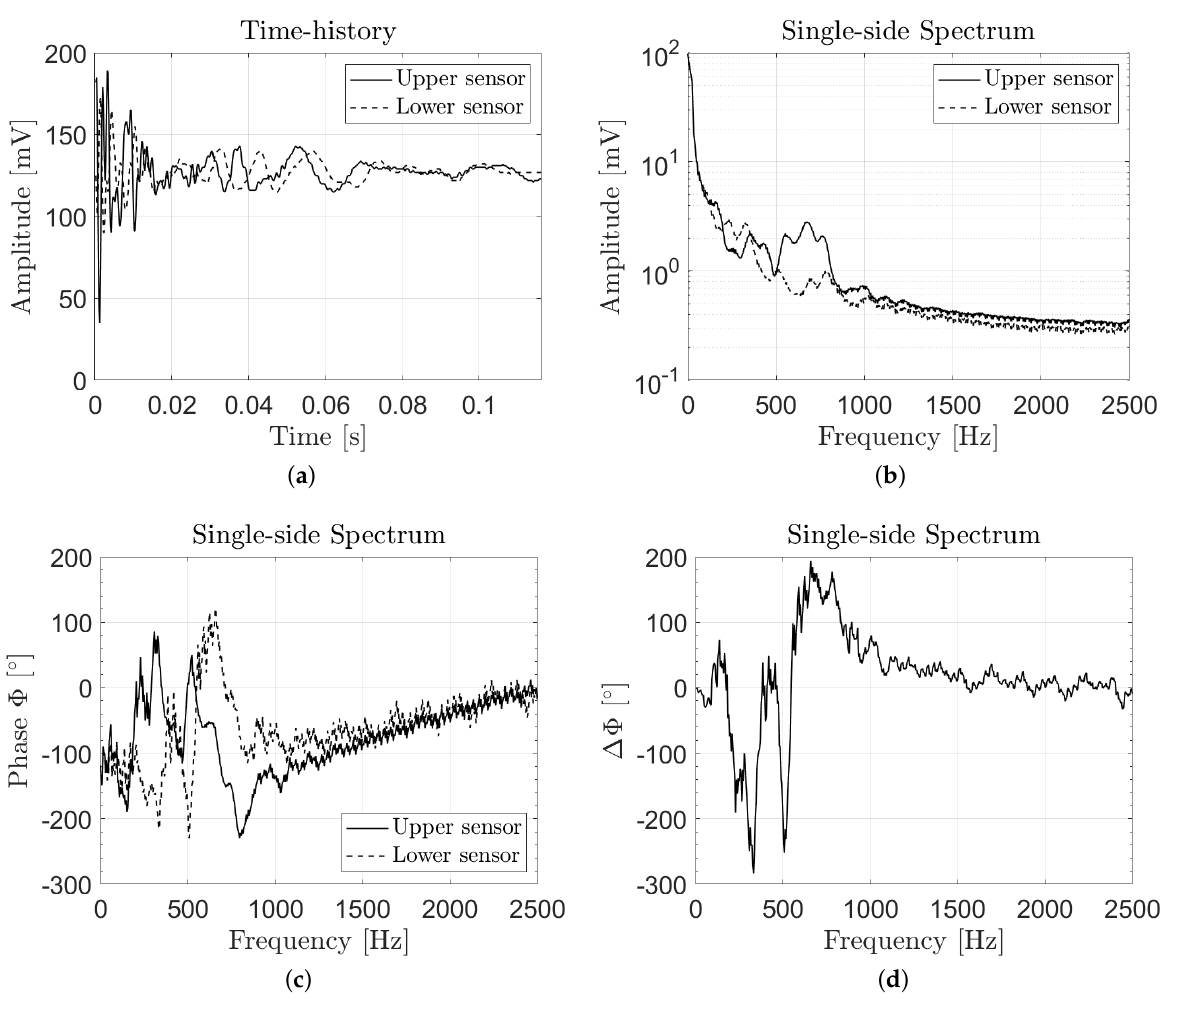
Figure 2. ( a ) Time history, ( b ) Amplitude, phase ( c , d ) difference of phase of two recorded signal corresponding to a 10 m depth.